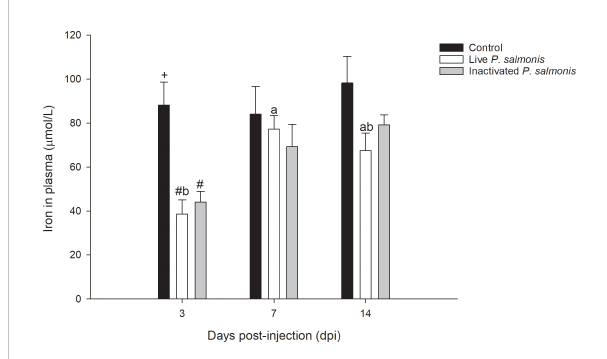
FIGURE 3 Plasma iron levels in S. salar. The samples were taken at 3, 7, and 14 days after injection (dpi). Black bar: control condition, white bar ( fi sh stimulated with live P. salmonis ), and gray bar ( fi sh stimulated with inactivated P. salmonis ). Symbol (#) over the bars indicates statistical differences between the different treatments at the same time points. Different letters a, b indicate statistical differences in the same treatment at different times. Two-way ANOVA, p < 0.05; n=6.